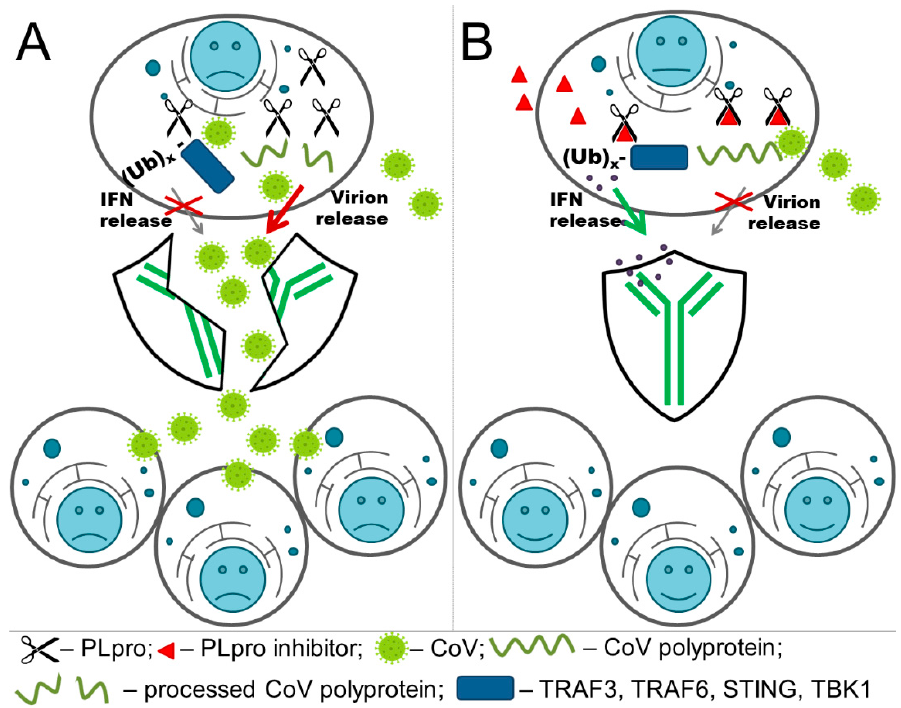
Figure 1. ( A ) Coronaviruses (CoV) papain-like proteases (PLpro) processes viral polyproteins, and thus promotes viral replication. Simultaneously, PLpro removes ubiquitin (Ub) chains and interferon-stimulated gene 15 product (ISG15) from the proteins involved in the antiviral immune response. Together, these factors produce viral spreading. ( B ) The inhibitor for CoV PLpro reduces the processing of the polyproteins, which prevent viral replication. Moreover, unimpaired immune response induces interferon (IFN) expression. All this results in suppression of viral